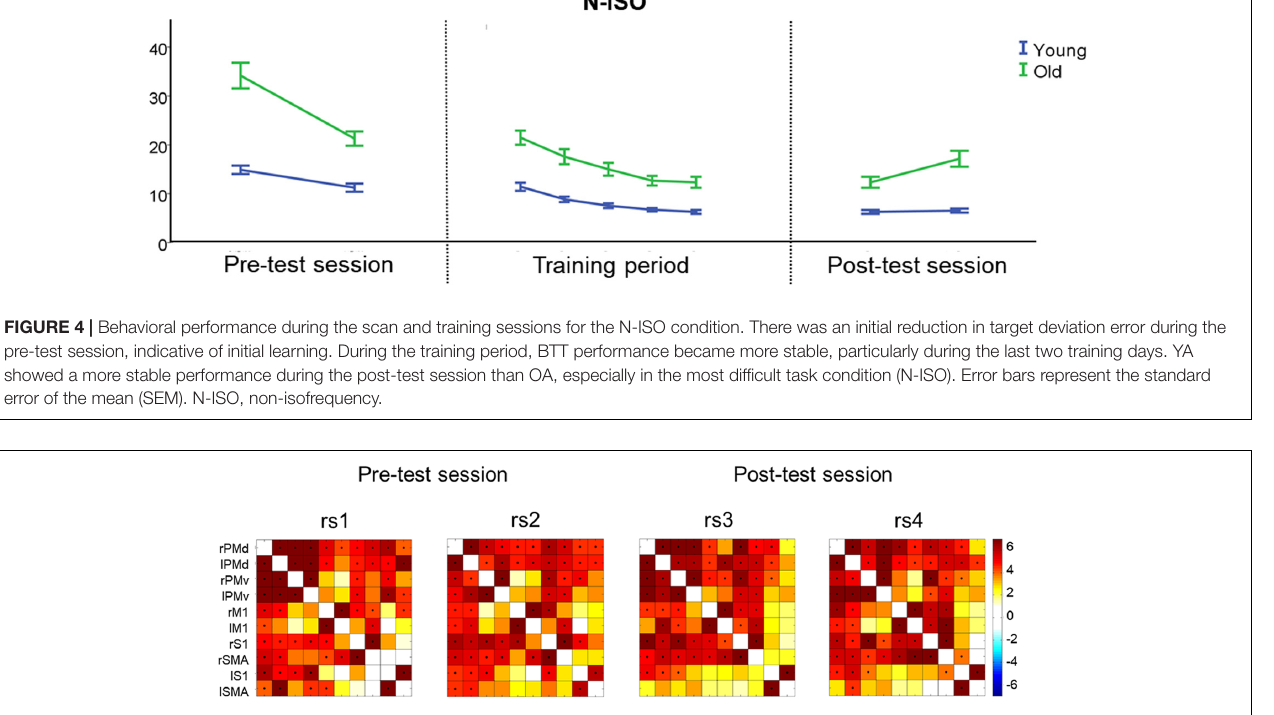
FIGURE 5 | Correlation matrices across all participants showing the strength of functional connectivity between each pair of regions from the motor network for the four rest scans collected in the present study. Significant correlations (Bonferroni corrected probability, p < 0.001) are indicated with a black dot. Color bar on the right indicates t